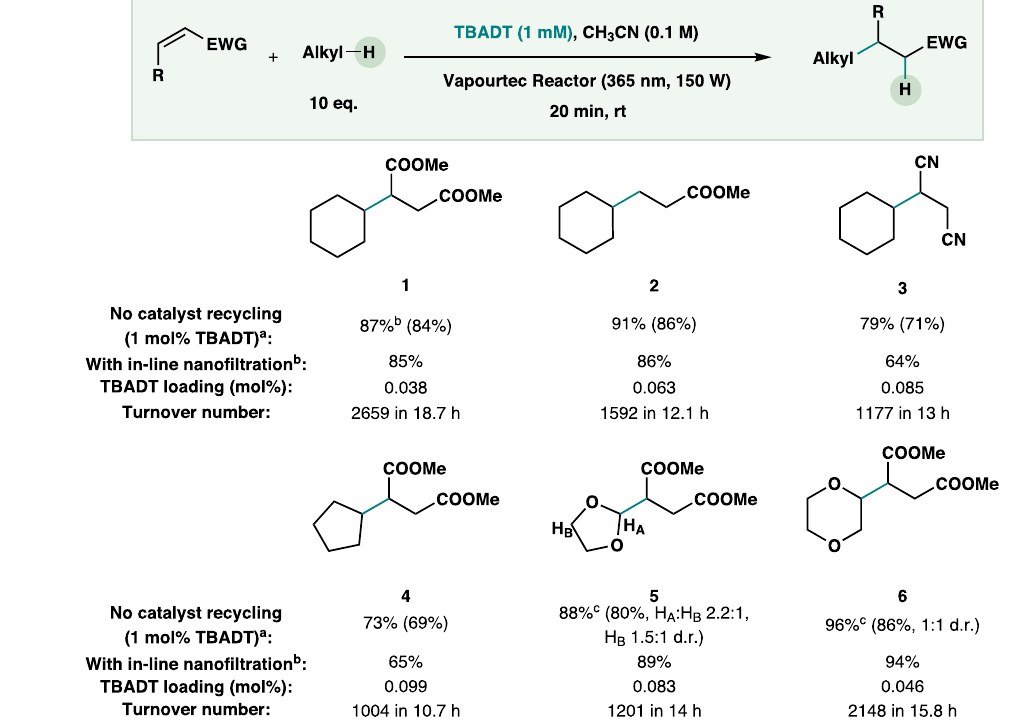
Fig. 6 | Scope of the photocatalytic C(sp 3 ) – H alkylation executed with in-line TBADT recovery. a Reaction conditions for single run without catalyst recycling: alkene (0.1M), H-donor (10 equiv), TBADT (1mol%) in CH 3 CN (5mL). Irradiation source: λ =365nm (150W), residence time: 5min (see the Supplementary